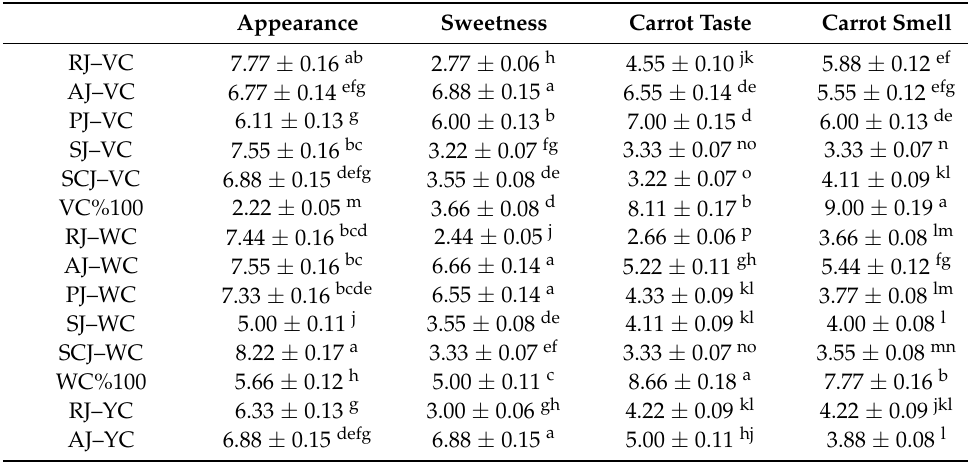
Table 5. Sensorial characteristics of carrot blended